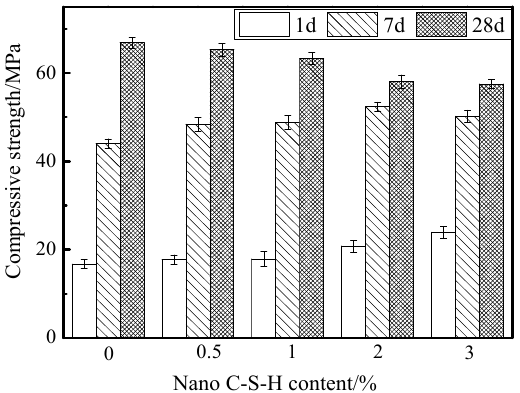
Figure 4. Compressive strength of cement pastes with the addition of different contents of nano C-S-H at the age of 1, 7, and 28 days.